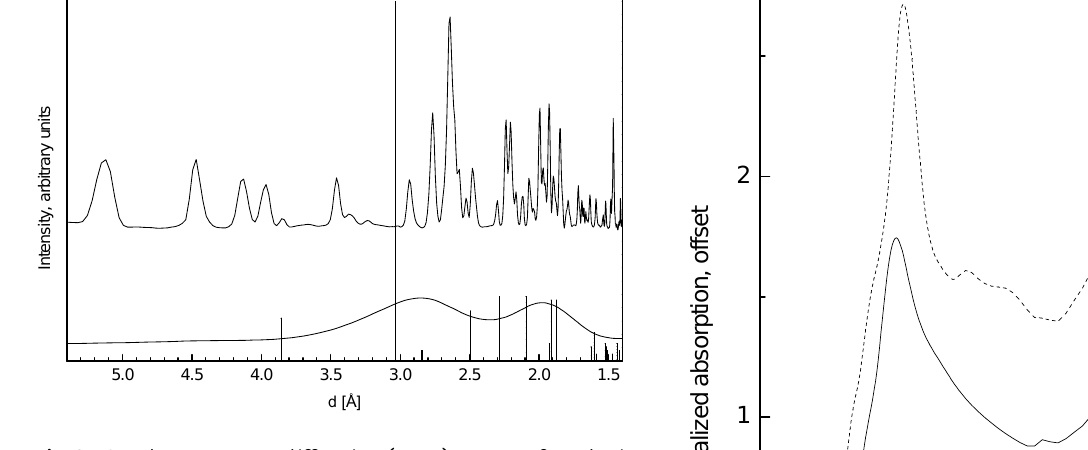
Fig. 3. Synchrotron X-ray diffraction (XRD) pattern of synthetic ikaite (upper panel) and of ikaite from Antarctic sea ice, decom- posed to amorphous calcium carbonate (lower panel). Additionally, the line pattern of calcite is shown to demonstrate the similarity of the diffractogram of decomposed ikaite to the one of amorphous calcium carbonate (ACC) in Crustacean Orchestia cavimana (Raz et al., 2002).